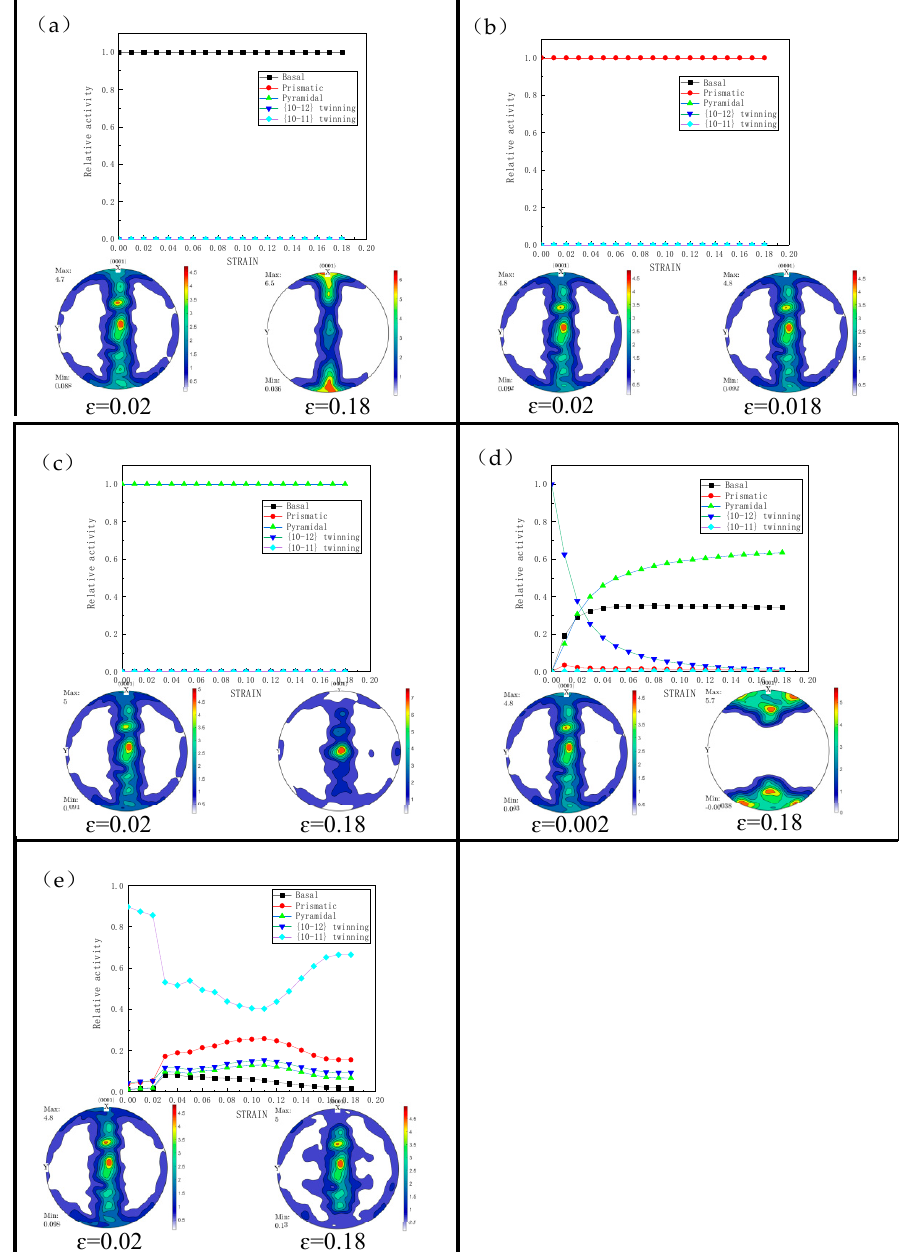
Figure 11. The relative activities of slips and twinning and the simulated texture evolution compression in the ED with ( a ) basal slip, ( b ) prismatic slip, ( c ) pyramidal slip, ( d ) {10-12} twinning, and (e) {1012} twinning as the predominant deformation mode.